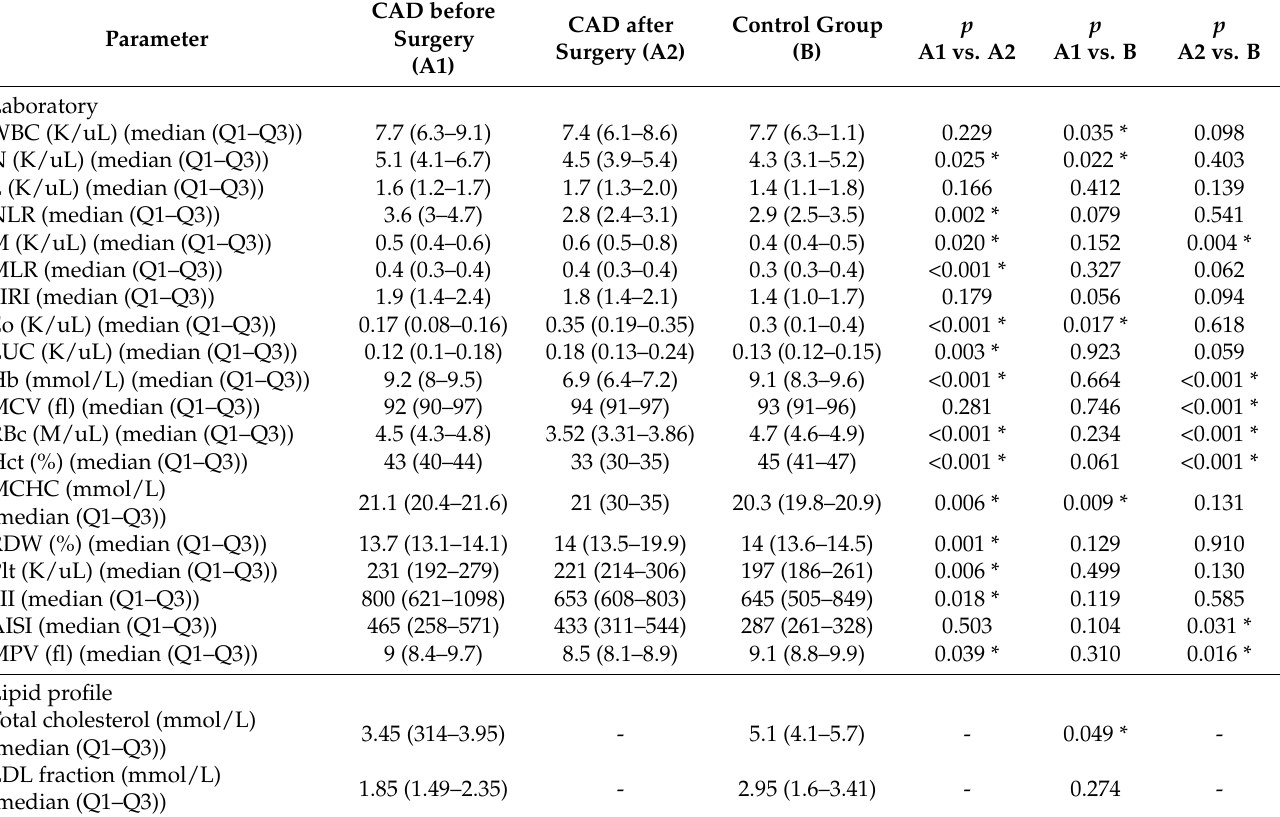
Table 2. Laboratory test